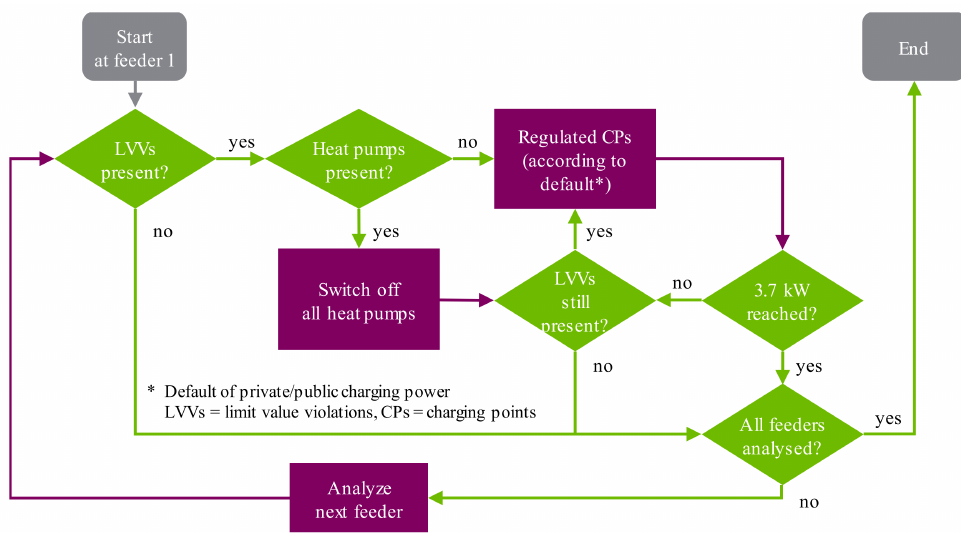
Figure 10. Basic operating principle of dynamic load management.